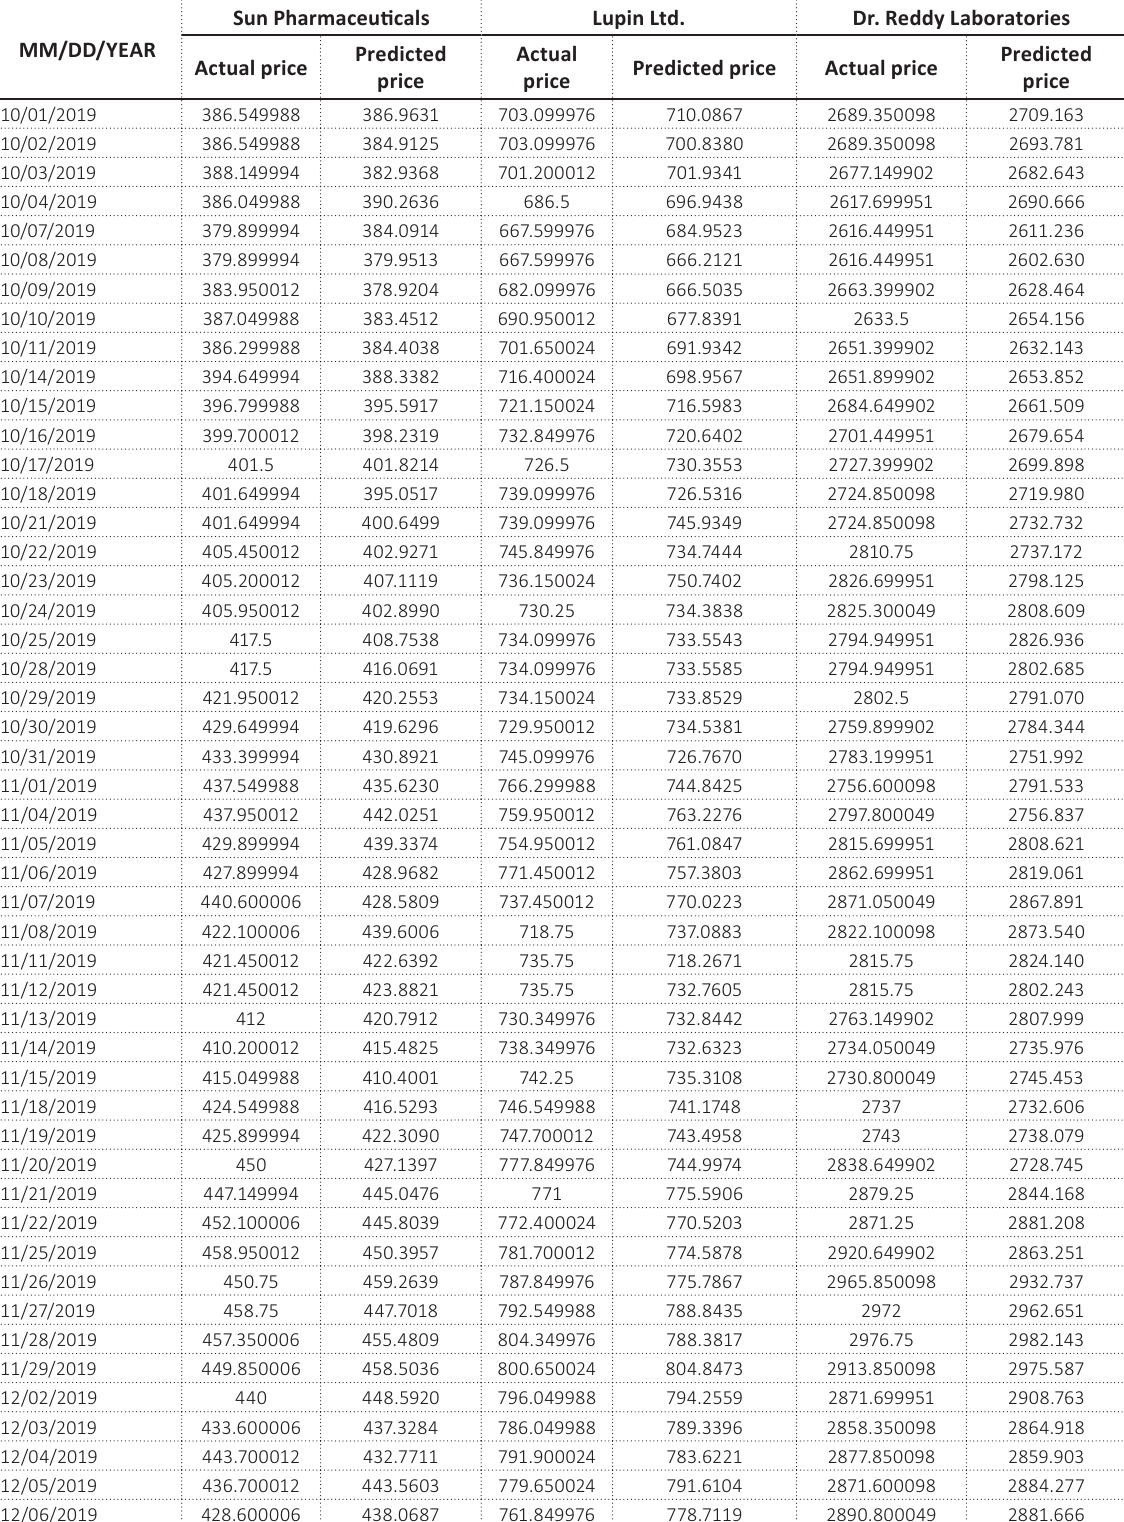
Table A1. Actual and forecasted prices of Sun Pharmaceutical Industries Ltd., Lupin Ltd. and